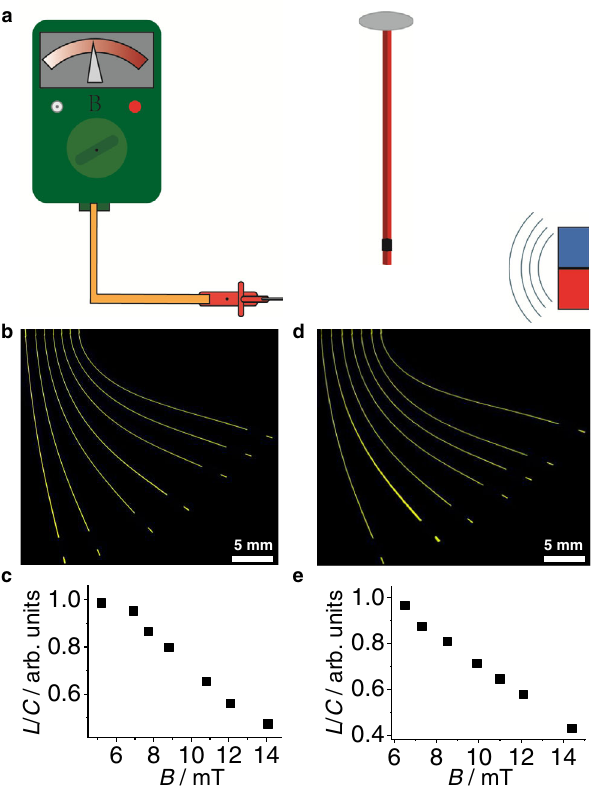
Fig. 5 Experimental setup and results of effect of the magnetic fi eld on crystal bending. a Schematic of the experimental setup. The magnet approaches a vertically standing crystal from the right side, and the de fl ection is recorded on the opposite side. b , d Images showing the bending of crystals of MNP// 4 in the test ( b ) and ( d ) while they were being approached with the magnet. c , e The ratio of the chord length ( L ) and arc length ( C ) of the crystal plotted against the magnetic fi eld strength ( B